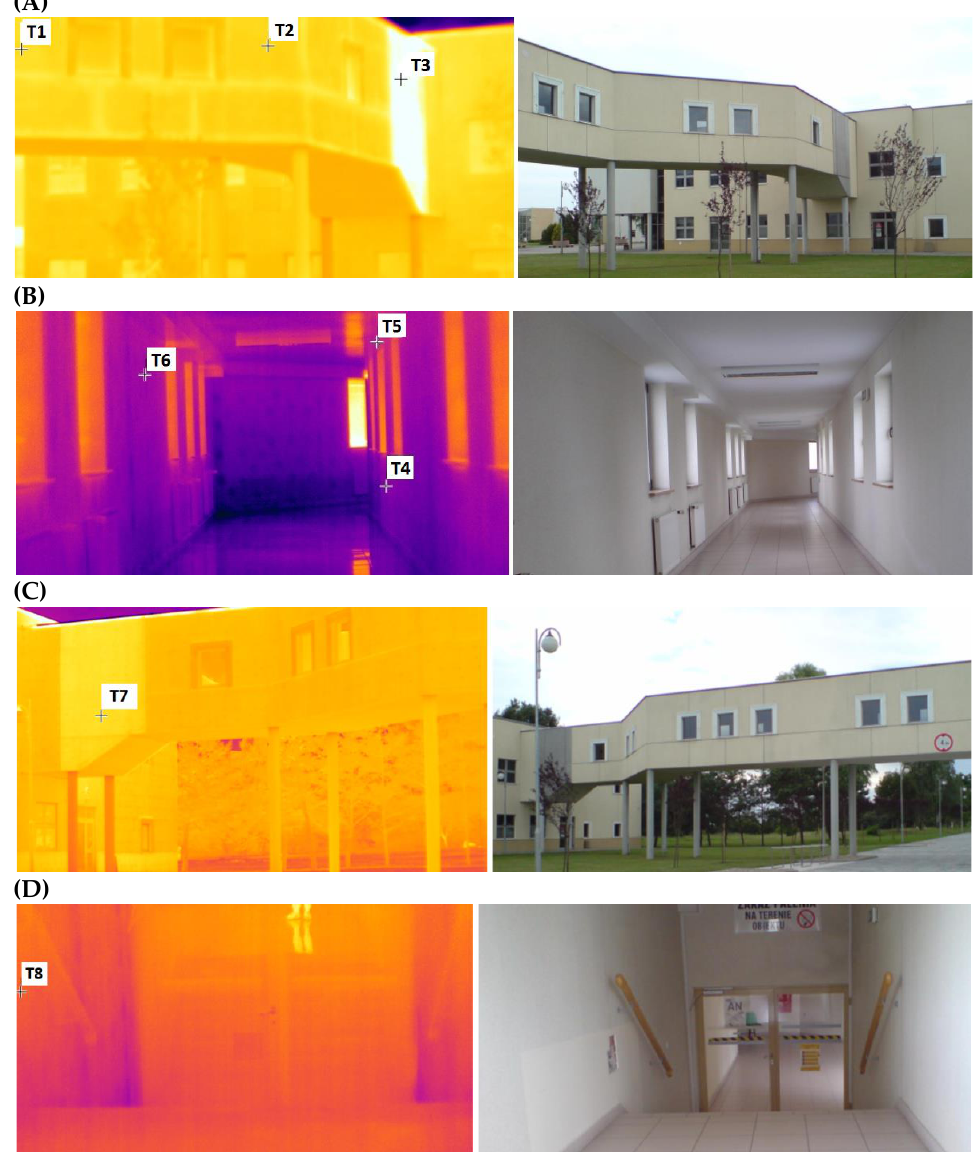
Figure 6. Point temperature distribution. ( A ) The location of the structure's external points for which the temperature was read. ( B ) The location of the structure’s internal points for which the temperature was read. ( C ) The location of the structure's external points for which the temperature was read. ( D ) The location of the structure’s internal points for which the temperature was read. Based on geodetic measurements, it was possible to determine the horizontal and vertical displacements of the controlled points. The values of the determined vertical displacements ( dZ ) and their mean errors ( m dZ ) are summarized in Table 3.